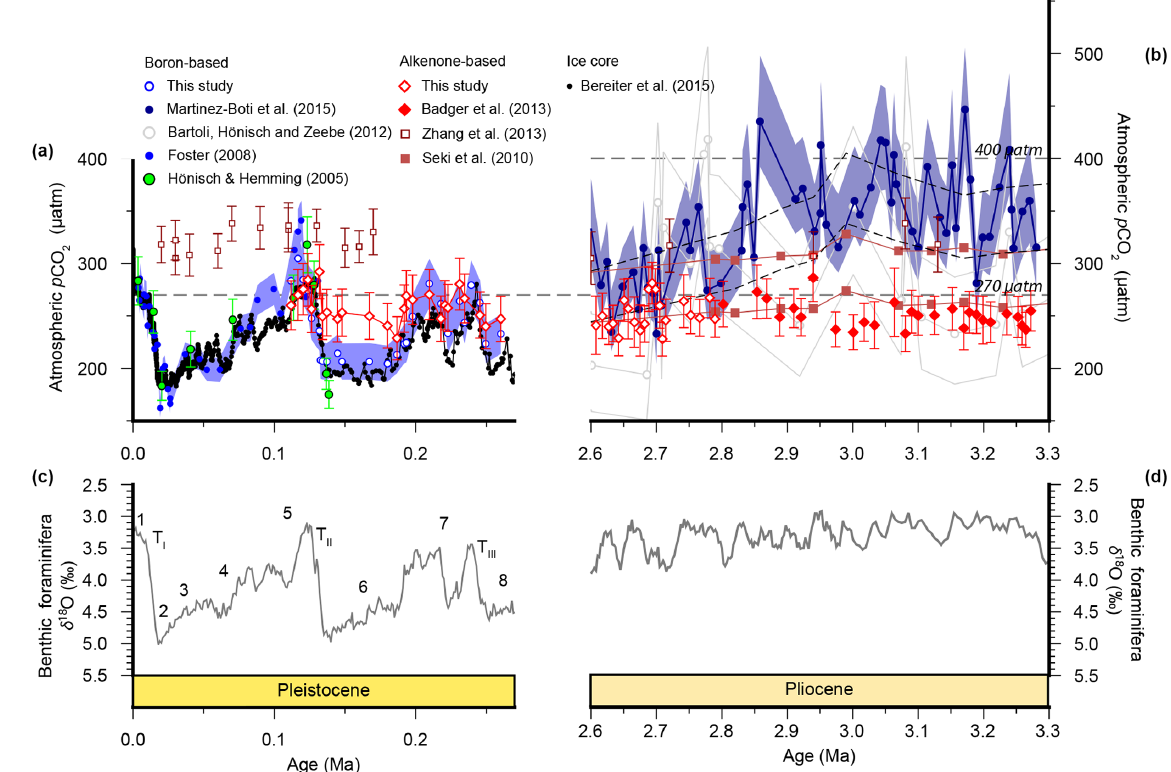
Figure 2. Atmospheric CO 2 reconstructions through the Plio-Pleistocene. (a) Published boron isotope CO 2( δ 11 Bplank) records from ODP Site 999: open blue circles (Chalk et al., 2017), filled bright blue circles (Foster, 2008; recalculated as described in the text), open grey circles (Bartoli et al., 2011), and filled dark blue circles (Martínez-Botí et al., 2015); and Deep Sea Drilling Project (DSDP) Site 668: filled green circles (Hönisch and Hemming, 2005). (b) Published CO 2( ε records from ODP Site 925: open maroon squares (Zhang et al., 2013); p − alk) ODP Site 999: filled red diamonds (Badger et al., 2013a); and ice core records: filled black squares (Bereiter et al., 2015 and Table 1), as well as our new alkenone isotope records from ODP Site 999 (open red diamonds). The lith size-corrected (dashed black envelope) and uncorrected (solid red envelope) data of Seki et al. (2010) are also shown. All records are shown with 1 σ uncertainties as described elsewhere. (c) The benthic foraminiferal stable oxygen isotope stack (Lisiecki and Raymo, 2005) with Marine Isotope Stage (MIS; numerals) and terminations ( T )